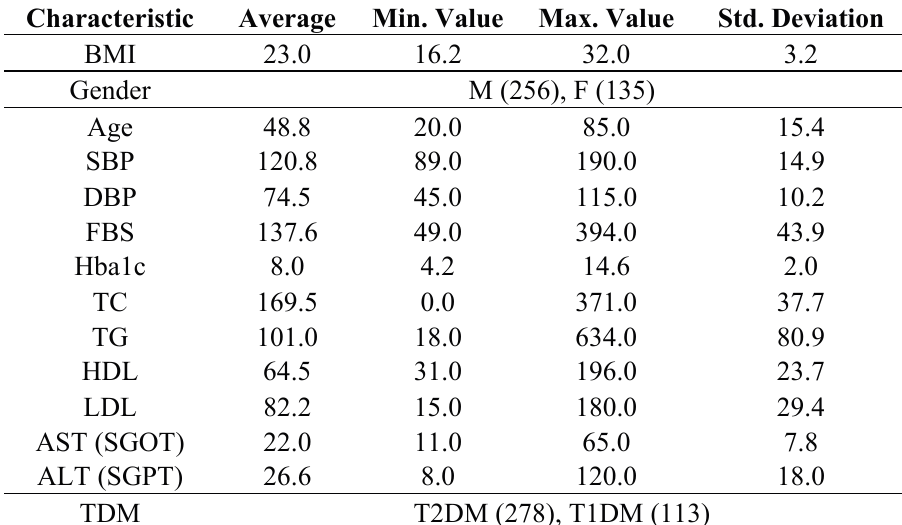
Table 4. Clinical characteristics of the diabetes